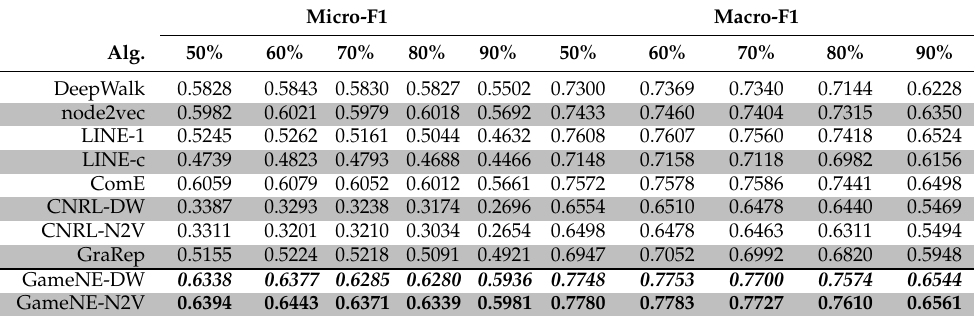
Table 8. Micro- and Macro F1-Scores of Multi-Label Classification, Network on =